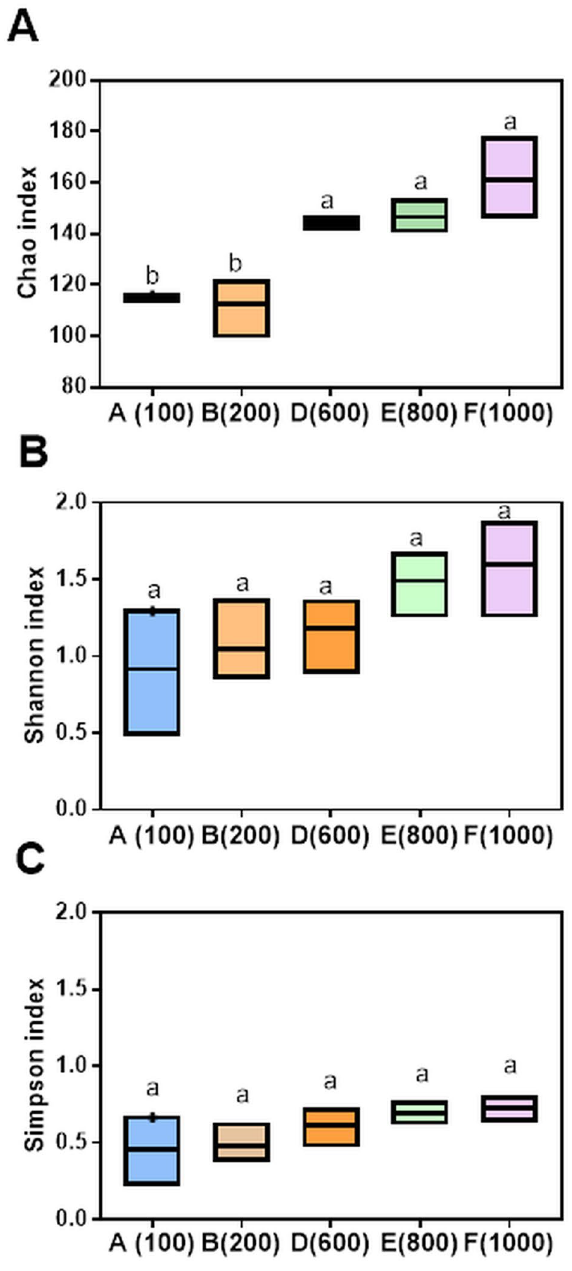
Figure 3. The α-diversity of fungi in Scots pine seed, based on Chao-1 ( A ), Shannon ( B ) and Simpson ( C ) indices. (A = 100, B = 200; D = 600, E = 800; F = 1000 seeds). Differences among five samples were analyzed. The same letters indicate no significant differences (T-test; P <